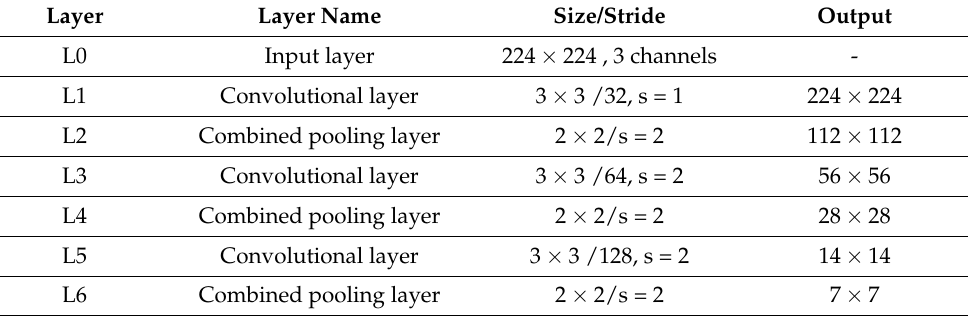
Table 2. Parameter settings of the DCAE-ELMNet and MRELM-AE joint network. Layer Layer Name Output